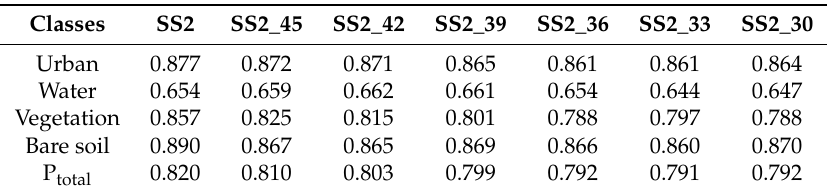
Table 24. Probabilities of correct classification depending on compressed image quality for Set 2, AGU coder, NN classifier.